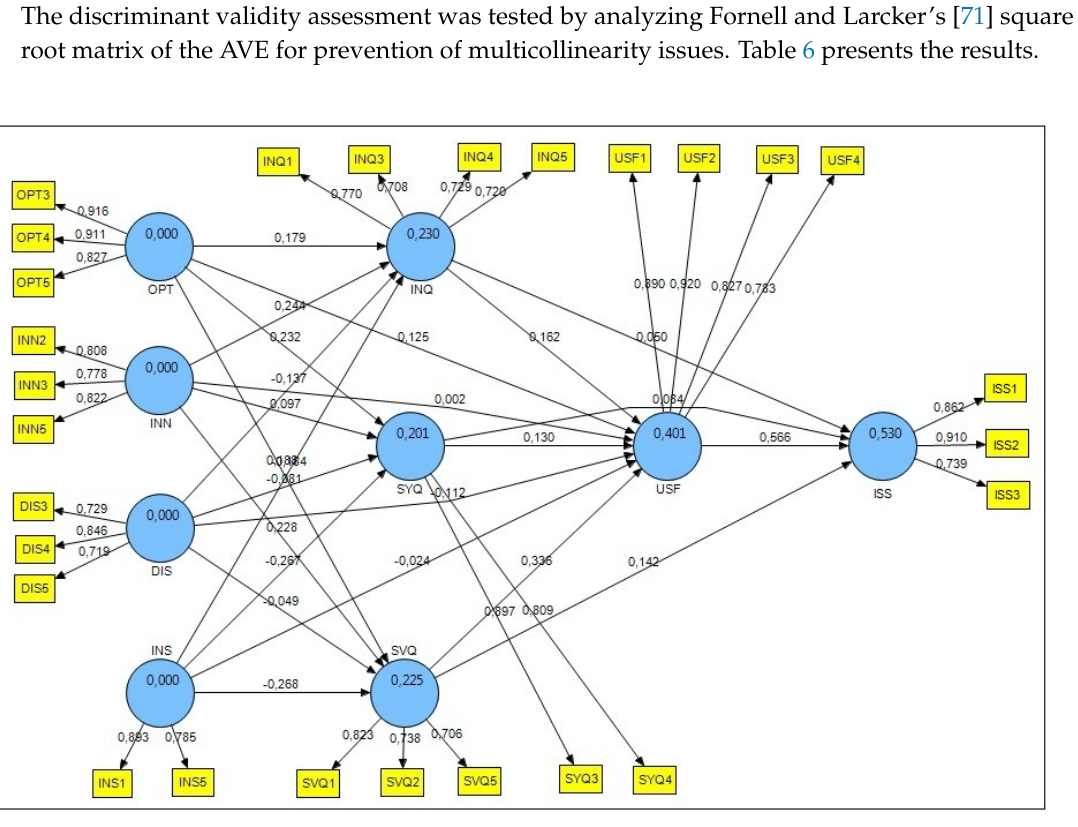
Table 4. Influences of readiness issue on the success of u-learning.